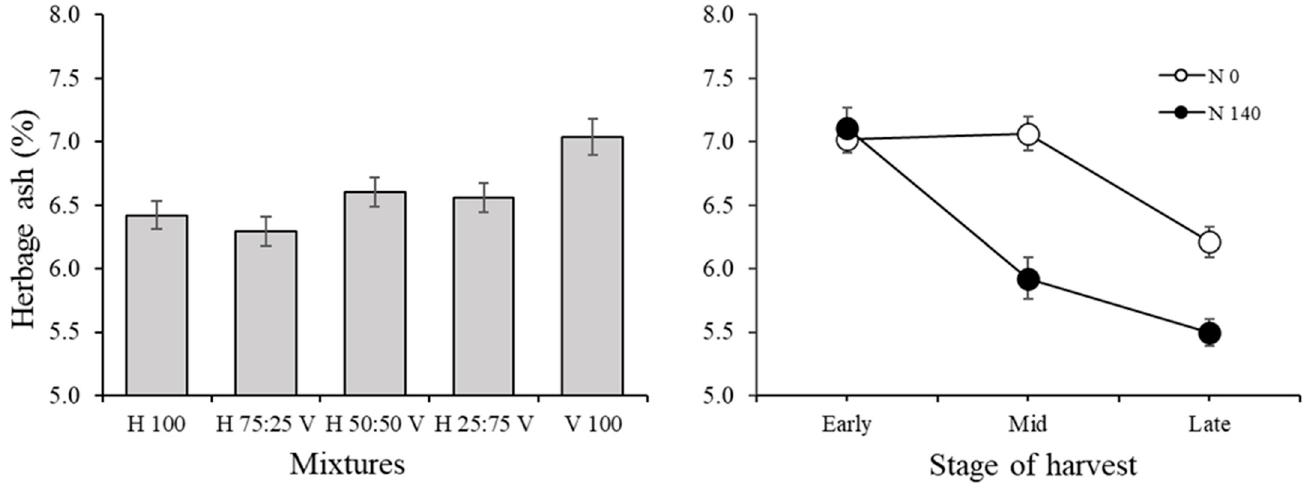
Figure 4. Herbage ash concentration as affected by MX mean effect ( left ) and SH × NF interaction ( right ). On the left, values are LSmeans across all treatments along with standard error estimate of the LSmeans since the design was unbalanced between the faba bean crop ( n = 9) compared to the mixtures and the barley crops ( n = 18). On the right, only data of the barley-containing treatments were used. Each point represents the arithmetic mean ( n = 24) and its computed standard error.